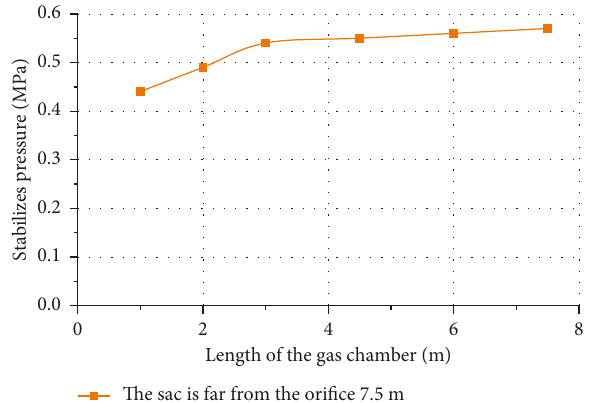
Figure 15: Effect of air chamber length on stable pressure when the sealing hole segment is 7.5m from the orifice.